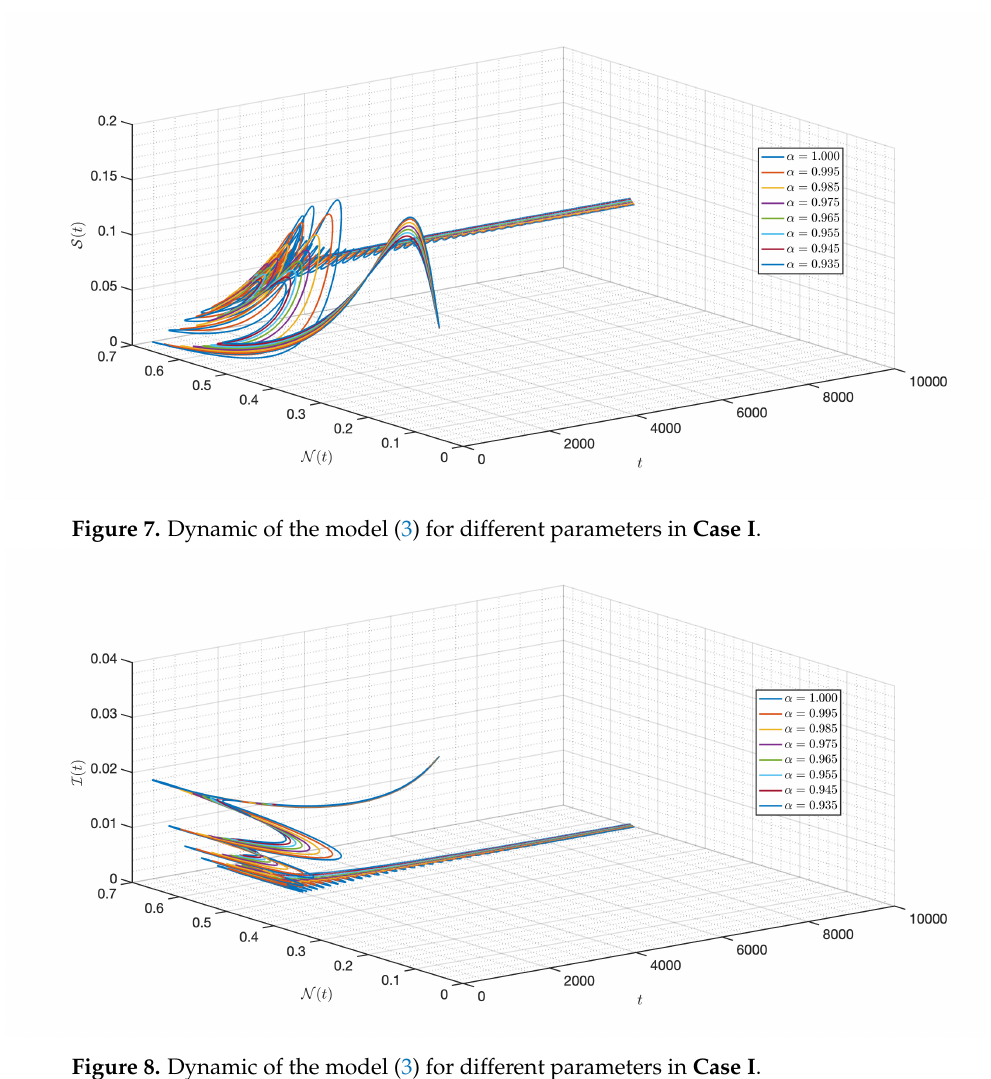
Figure 8. Dynamic of the model (3) for different parameters in Case I .